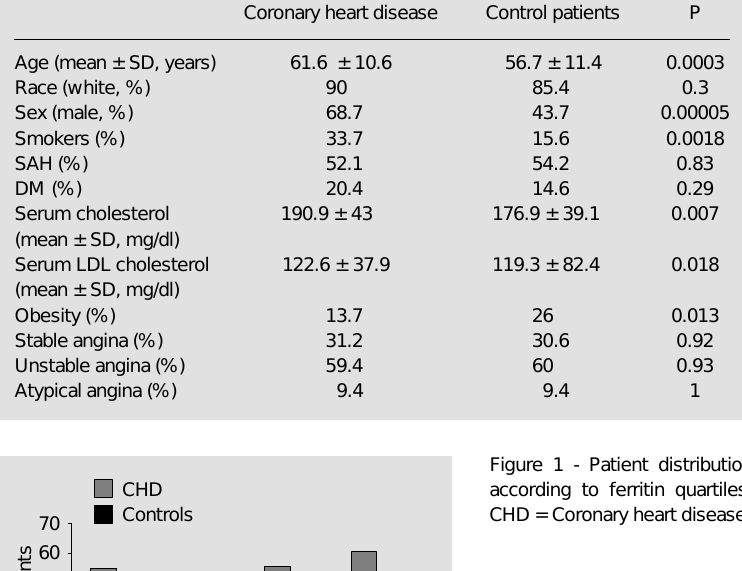
Figure 1 - Patient distribution according to ferritin quartiles. CHD = Coronary heart